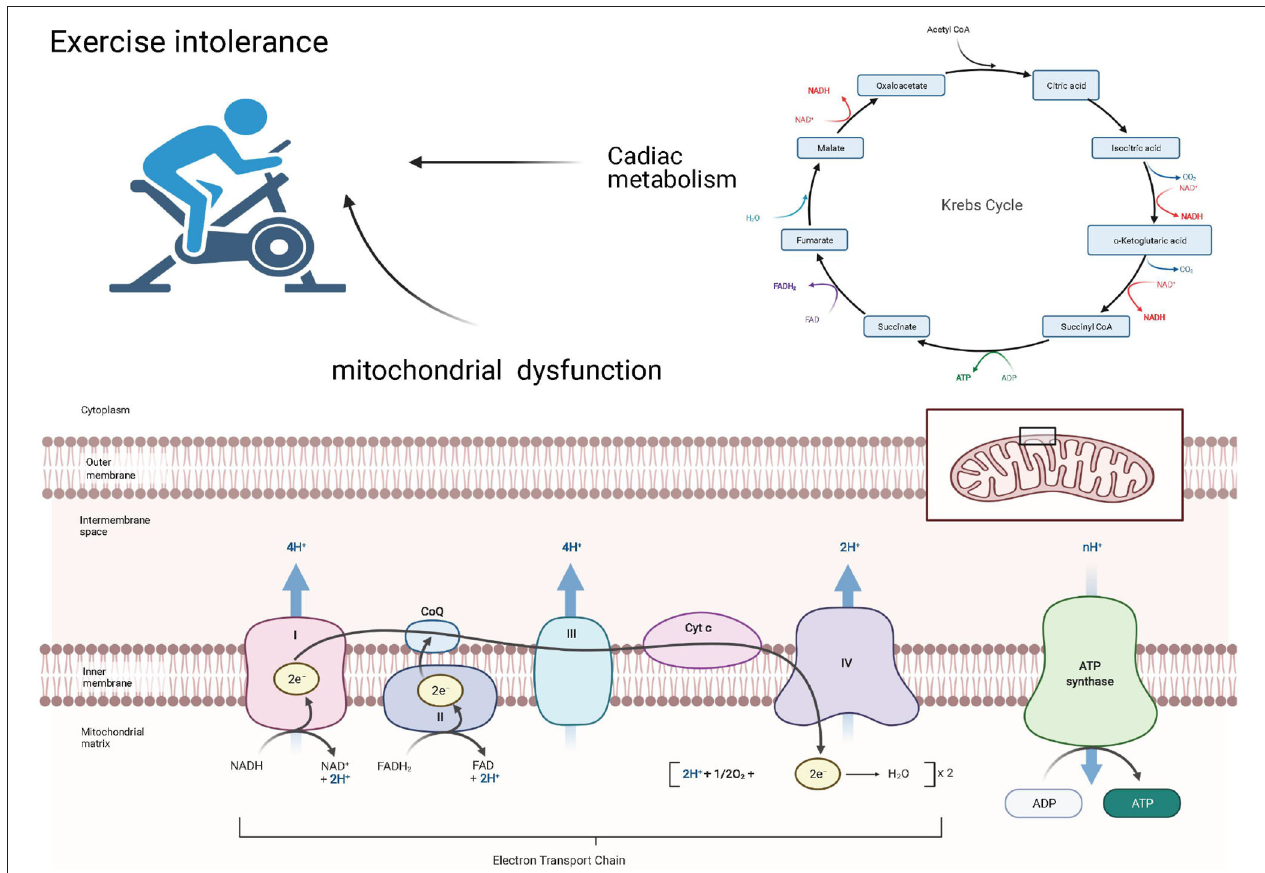
FIGURE 2 | Exercise intolerance associated with mitochondrial dysfunction and cardiac